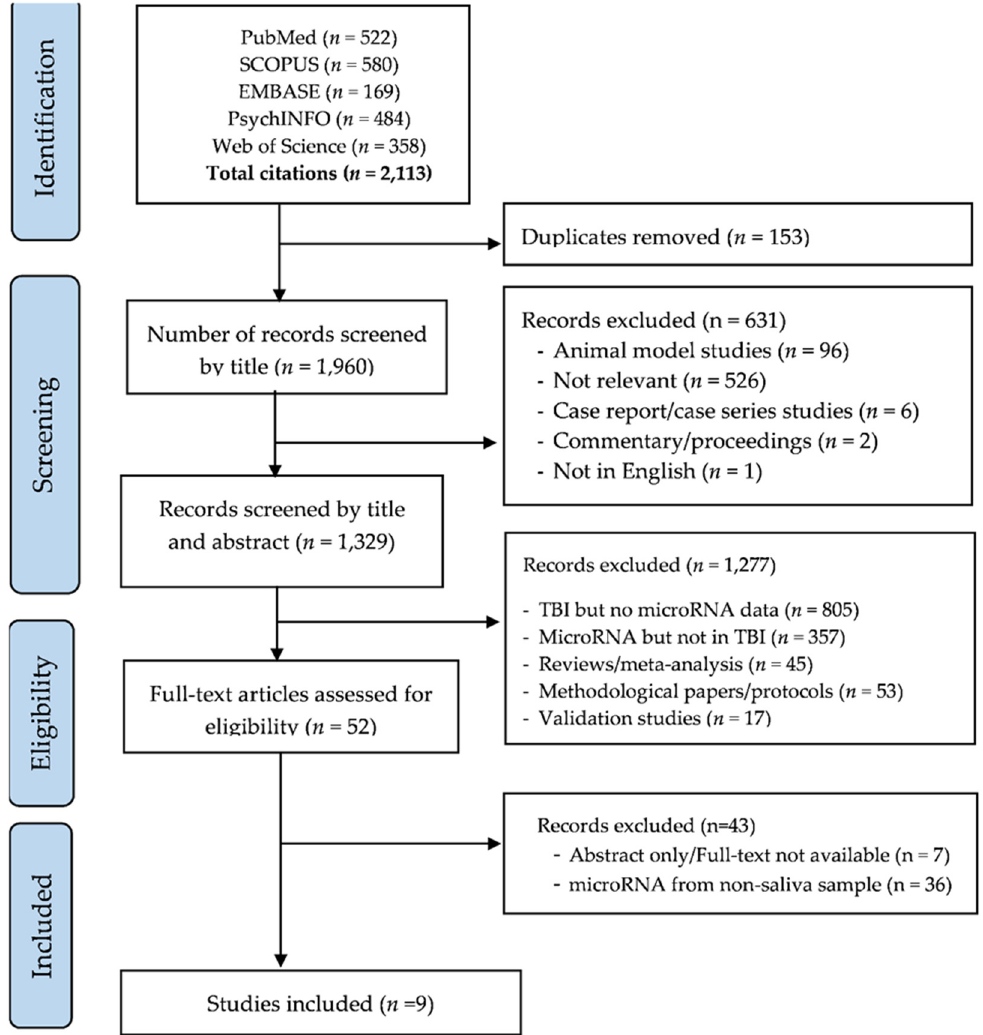
Figure 1. PRISMA flow diagram of screening and selection process.